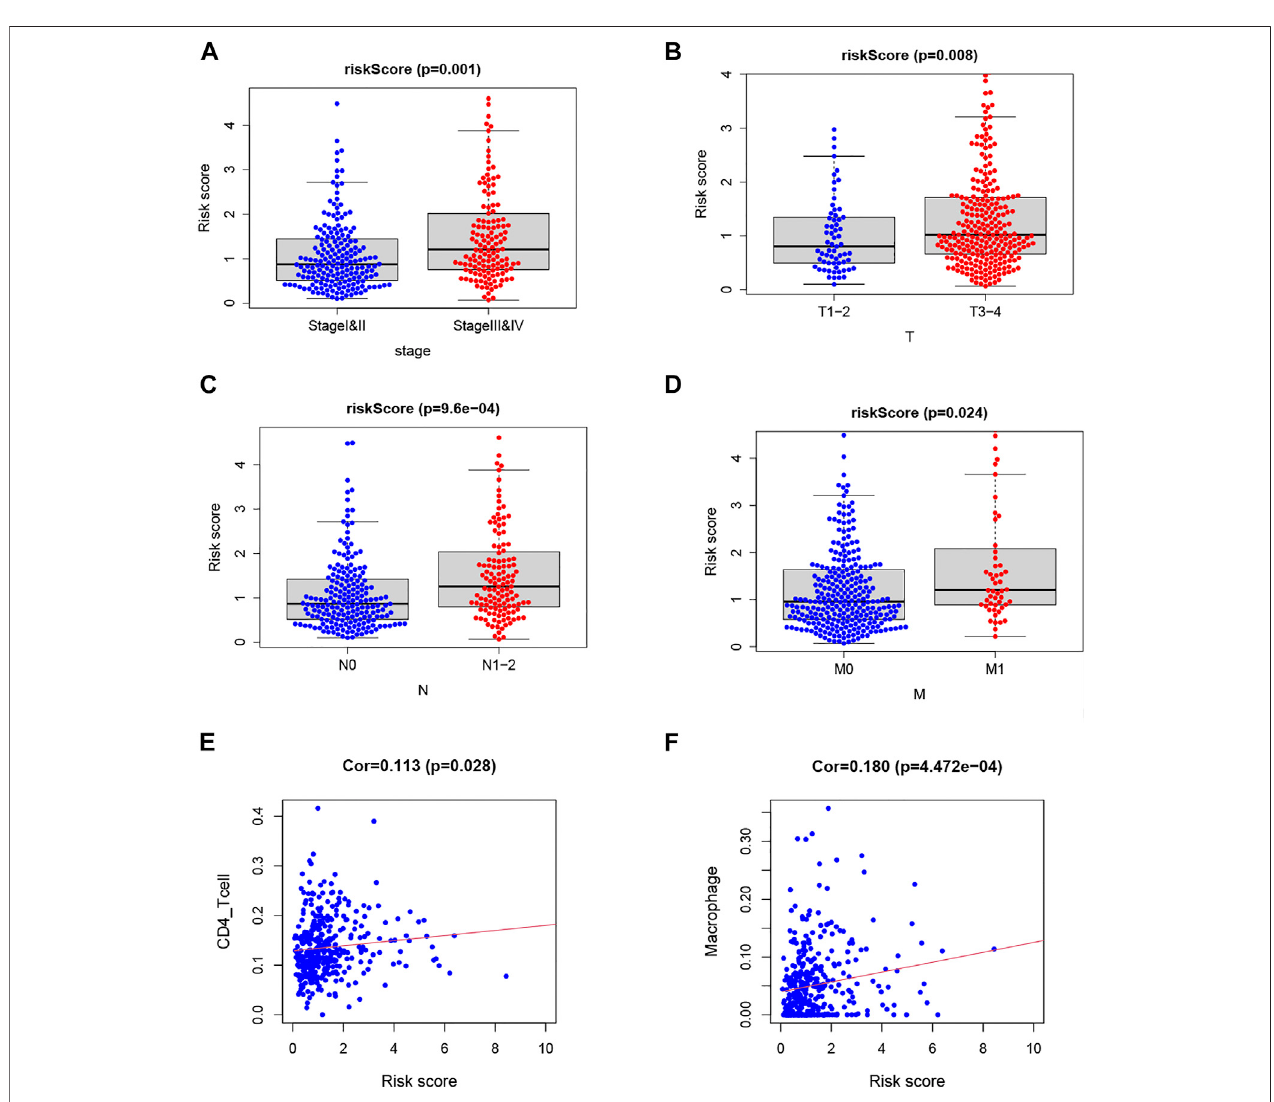
FIGURE 6 | Analysis of clinical and immunological relevance for riskScore. (A – D) Analysis of relationship between clinicopathological factors and riskScore. (E,F) Analysis of relationship between immune cells and riskScore.